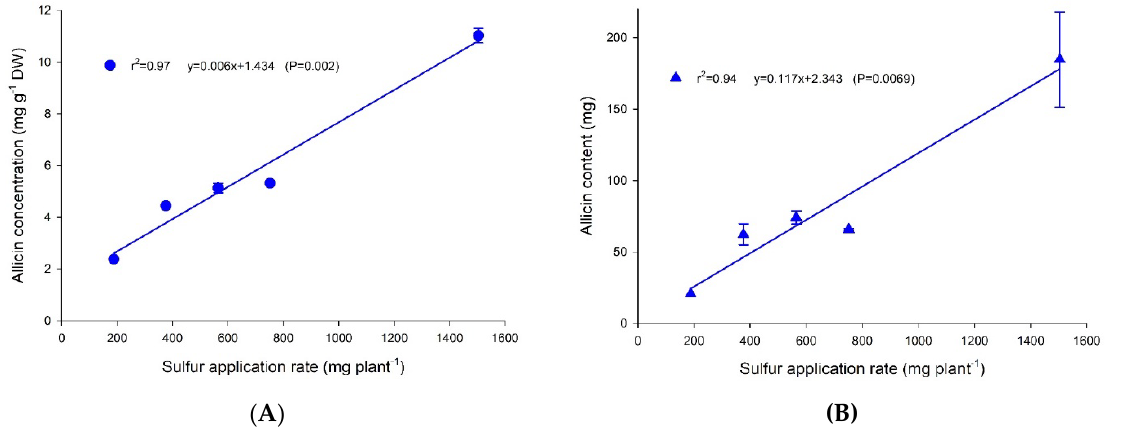
Figure 3. The relationship between sulfur application rate (mg plant −1 ) and ( A ) bulb allicin concentration (mg g -1 DW) and ( B ) allicin content (mg bulb −1 ) for garlic cultivar Glenlarge grown in a solution culture at a range of S supply (188–1504 mg plant −1 ). The 1128 mg plant −1 treatment was omitted due to bulbs rotting prior to analysis.